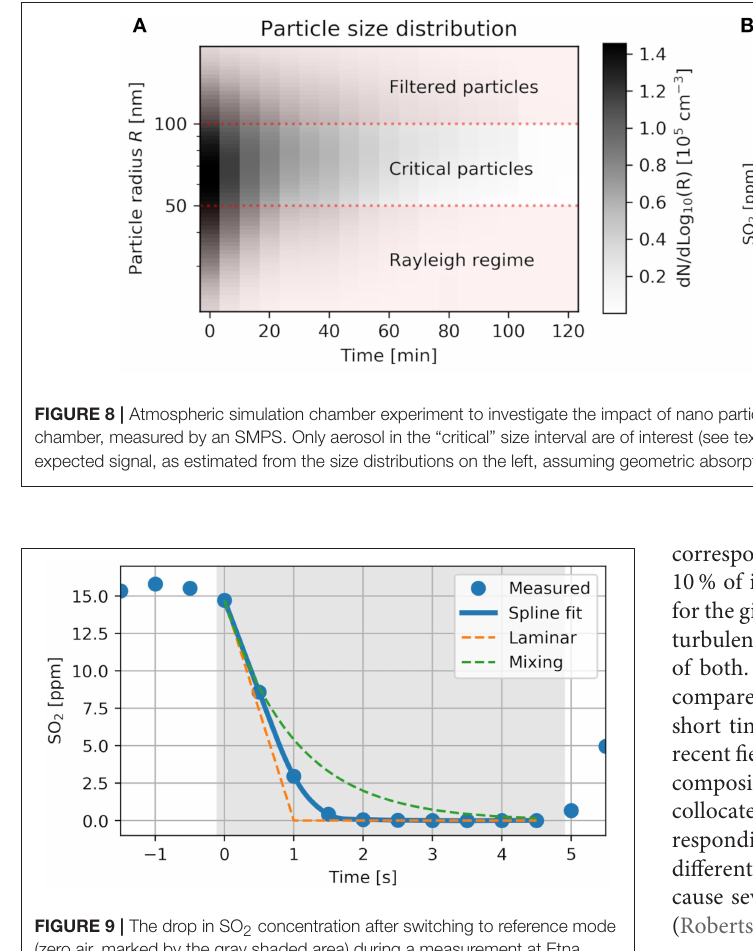
FIGURE 9 | The drop in SO 2 concentration after switching to reference mode (zero air, marked by the gray shaded area) during a measurement at Etna volcano. The blue points represent the actual data points, whereas the blue line is a quadratic spline interpolation, to allow determination of t 90 . Theoretical calculations for perfect laminar flow and turbulent mixing inside the cell are depicted by the dashed